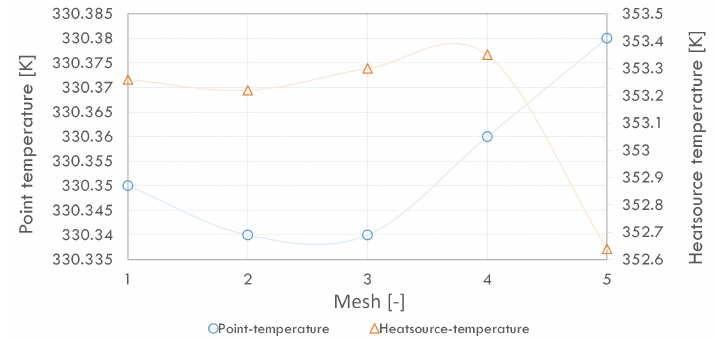
Figure 9. Effect of the grid on the temperature